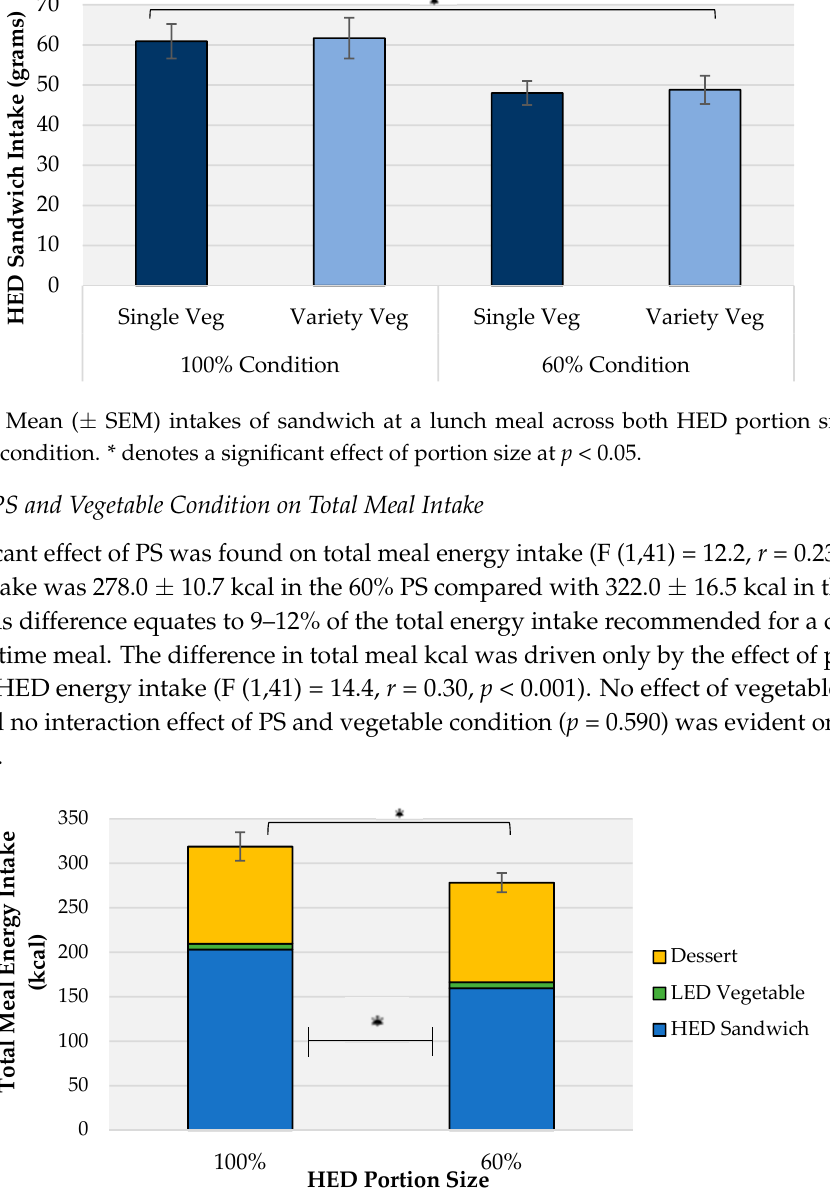
Figure 2. Mean (± SEM) intakes (kcal) of lunch components by HED portion size. Error bars show SEM for total meal intake *denotes a significant effect of portion size condition on at p <